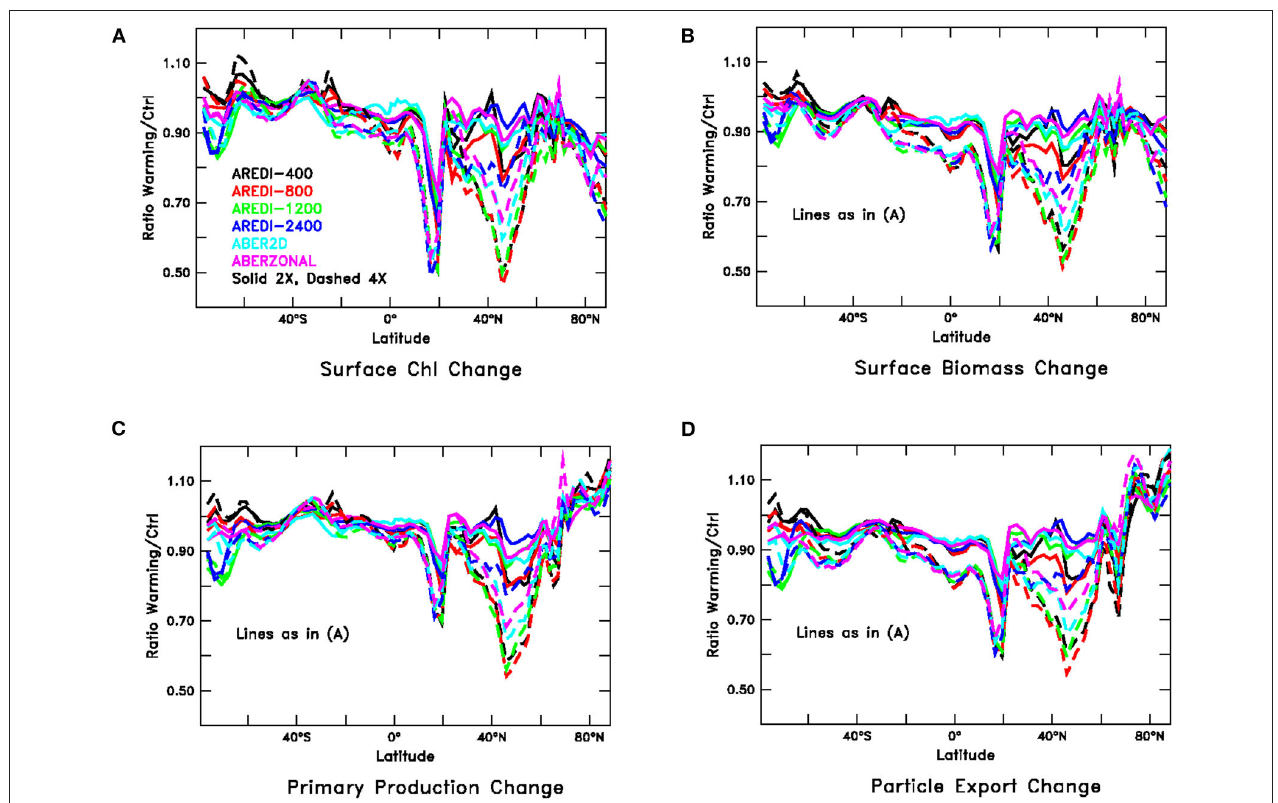
FIGURE 6 | Relative changes in zonally averaged biological fields under global warming (paralleling Figure 3 ), averaged over years 40–140 of high CO 2 simulations. Solid lines show 2xCO 2 , dashed lines 4xCO 2 . (A) Chlorophyll, (B) Particulate carbon, (C) Primary productivity, and (D) Particle export across